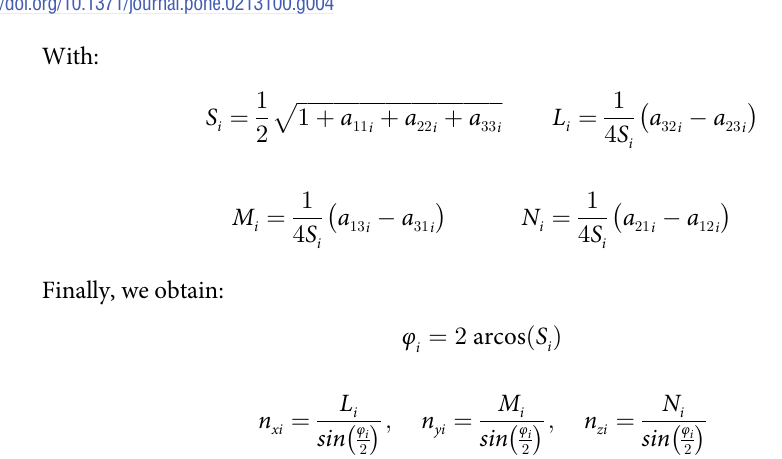
Fig 4. Rigid body displacement defined by the screw axis theory. ω part of the displacement, n i : direction vector of the screw axis, A i : orthogonal projection of O i on the screw axis.